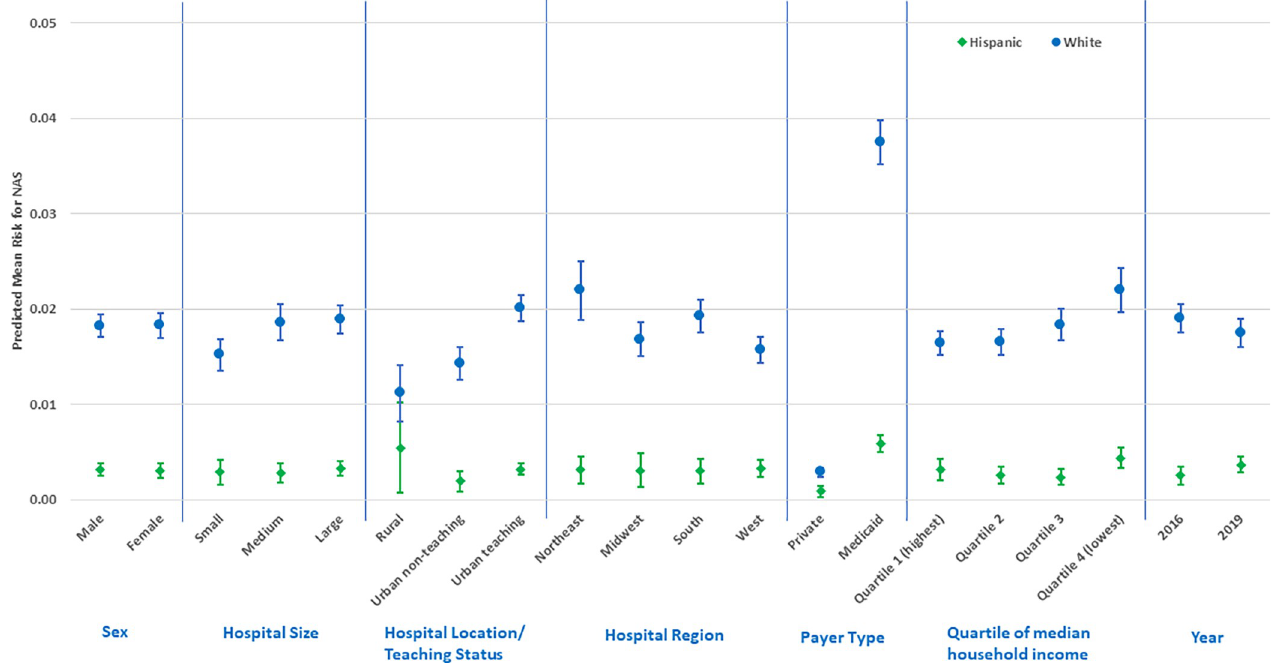
Fig 2. Predictive margins for factors related to the White/Hispanic NAS disparity (risk differences and 95% confidence intervals).